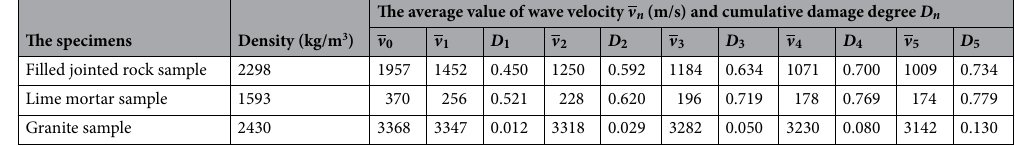
Table 1. Physical and mechanical parameters of rock and filled joint